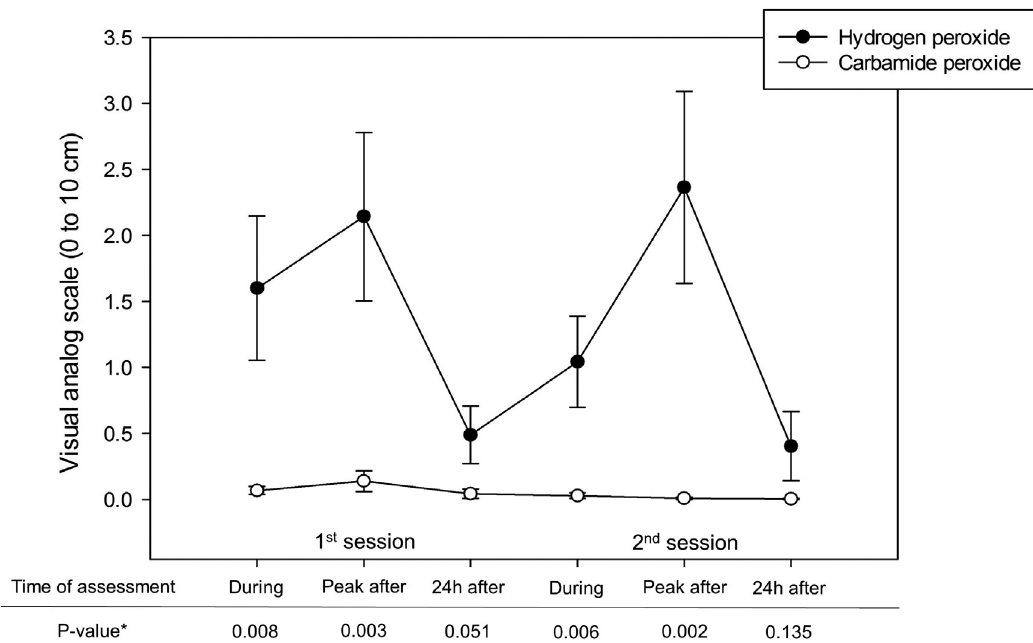
Figure 4- Mean (standard error) sensitivity levels reported by participants using the visual analog scale. * Calculated using the Mann- Whitney